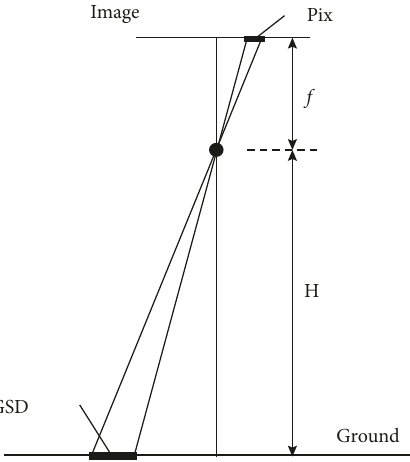
Figure 6: Dataset